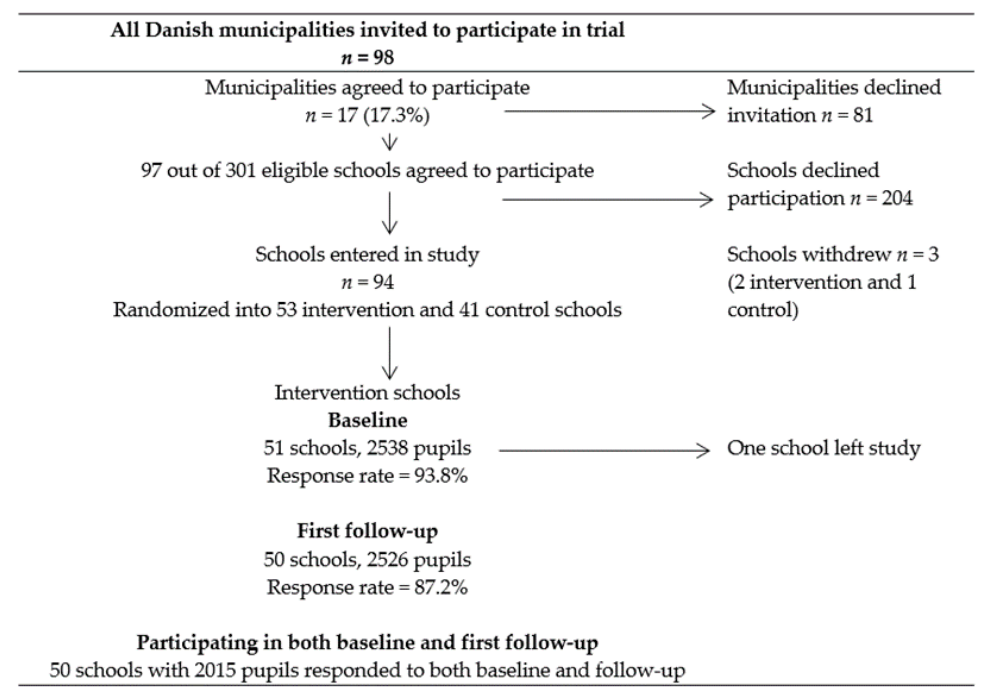
Figure 1. Flow diagram of recruitment, randomization, and participation in the X:IT study.